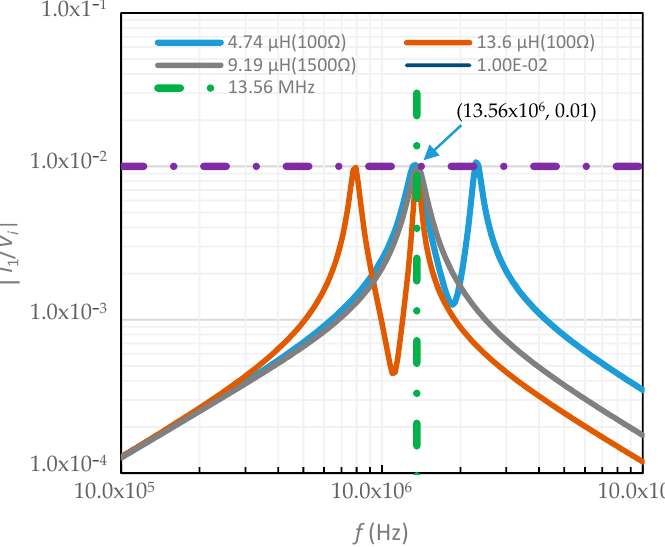
Figure 5. Matching condition of the symmetric CPT with inductance values of 4.74, 9.19, and 13.62 µH.